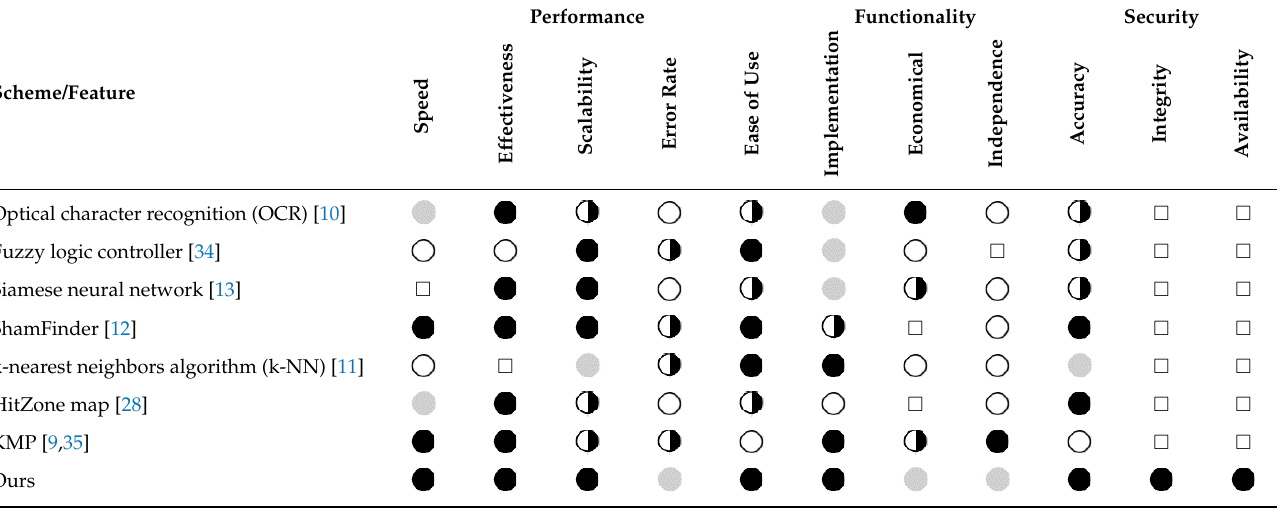
Table 4. Comparison with existing techniques. Figure 9. Phishing site .